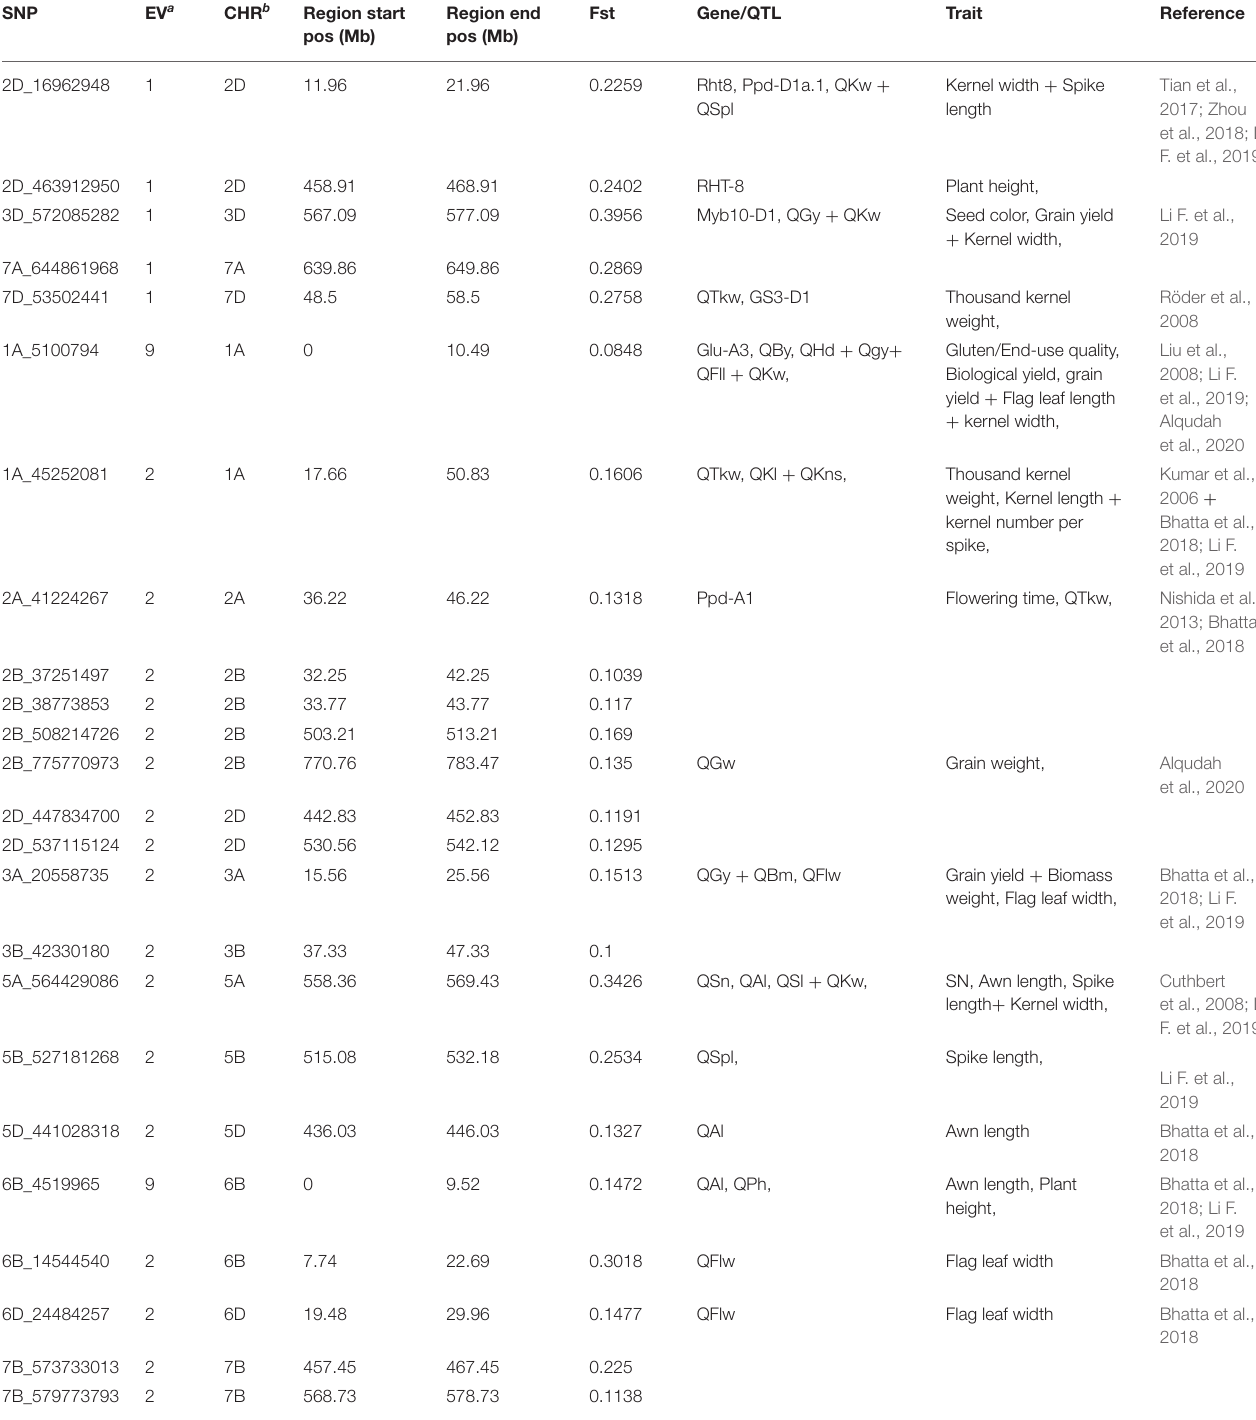
TABLE 5 | Top SNPs with a significance of –log 10 5.0 between SYN-DER, PC, and AL accessions. SNP EV a CHR b Region start Region end Fst Gene/QTL Trait pos (Mb) pos (Mb)